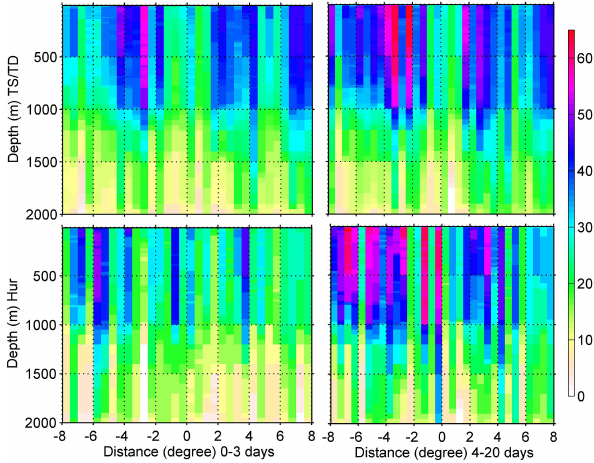
Figure 1. Count of TC-affected pairs in each 0.5 ◦ distance bin from − 8 ◦ to 8 ◦ across the storm track for two footprint compos- ites: TS/TD in the upper panel, hurricanes in the bottom panel. The statistics are conducted in two time periods: 0–3 days on the left, 4–20 days on the